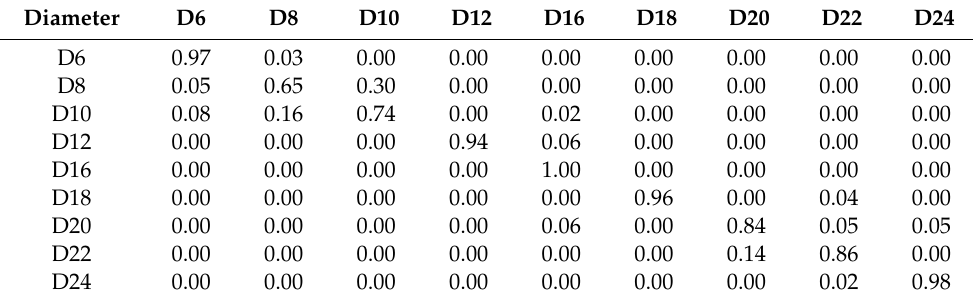
Table 6. Confusion matrix obtained by LSTM network on simulated datasets.